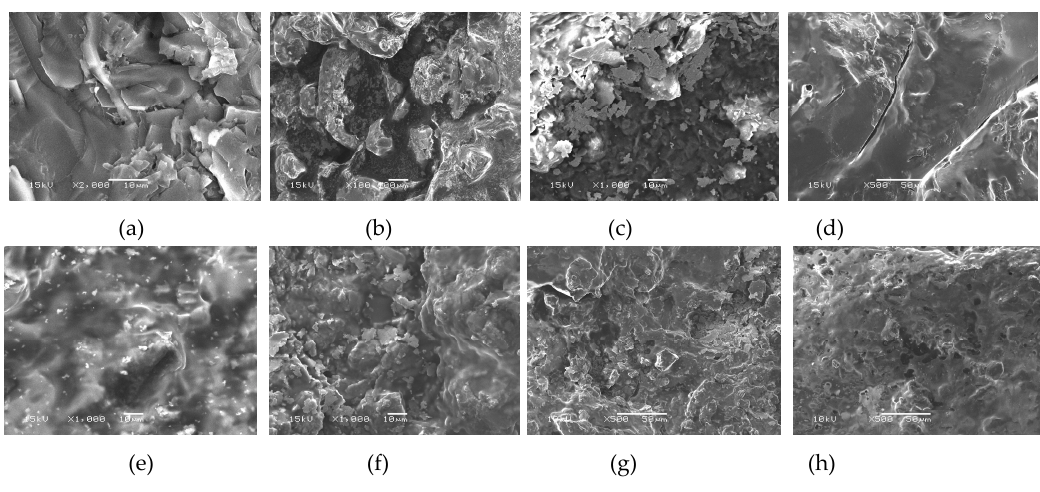
Figure 8. Coal and rock SEM results: (a) 2-2 coal; (b) Coarse sandstone; (c) Muddy siltstone; (d) Mudstone; (e) Carbonaceous mudstone; (f) Silt stone; (g) and (h) are Weathered bedrock.